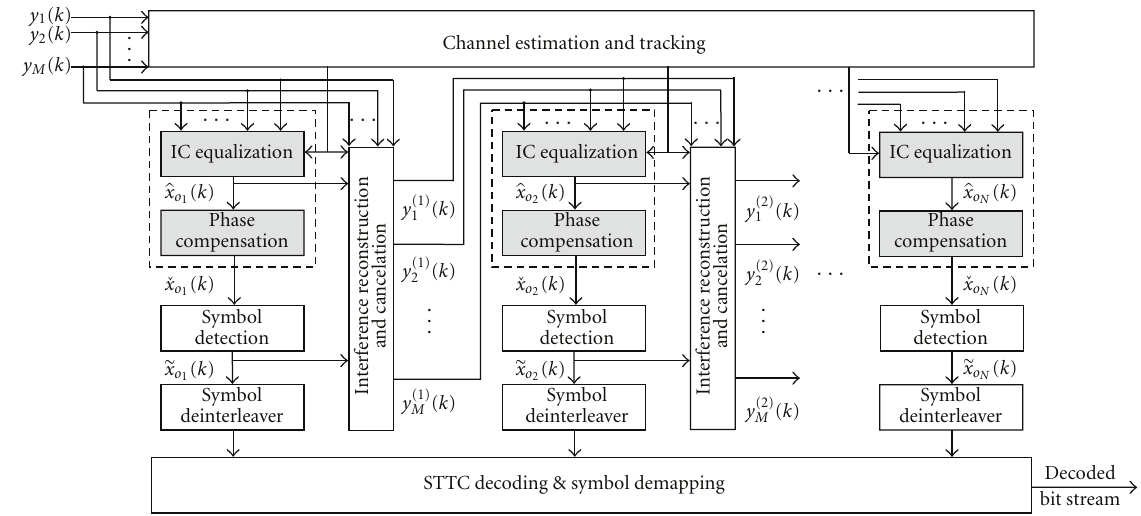
Figure 1: Layered MIMO receiver architecture adopting the proposed equalization (in each layer, an IC equalizer and a phase compensator perform interference cancelation and phase compensation separately).